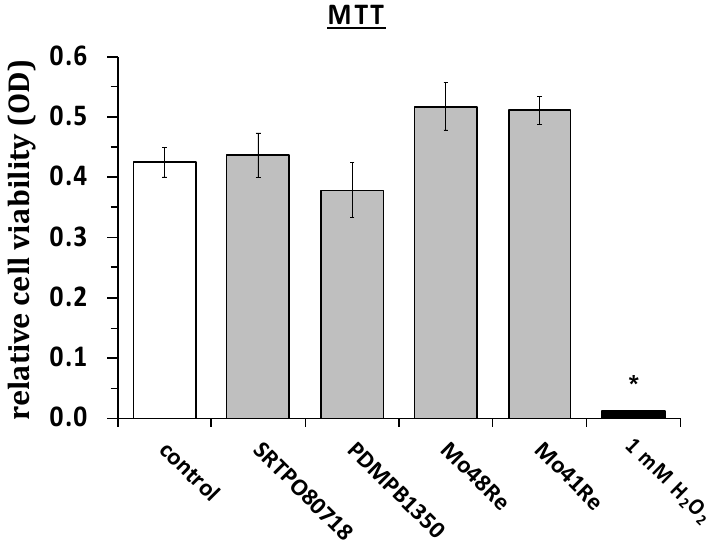
Figure 3. MTT assay with L929 mouse fibroblasts. *, p < 0.05 as compared to the control (paired two-tailed Student’s t -test).